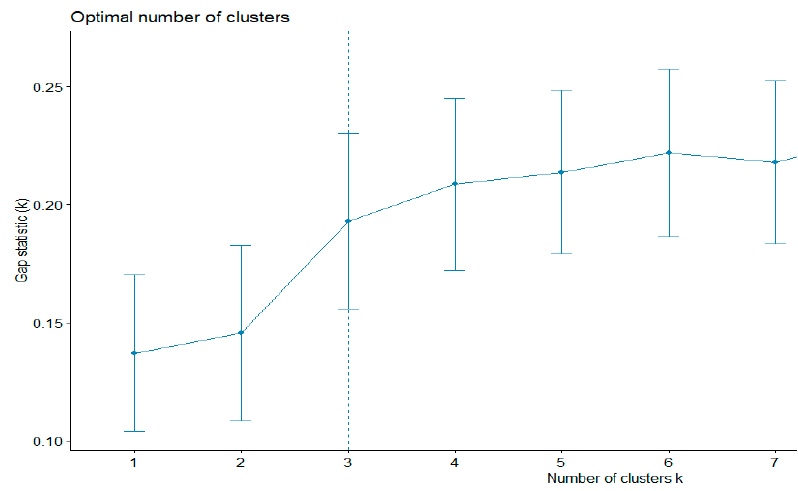
Figure 2. Applying the gap statistics method to find the optimal number of clusters.